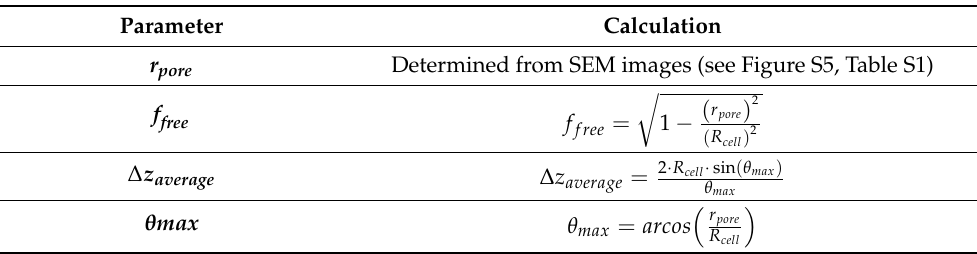
Table 2. Key topographic parameters investigated in this work (detailed description of geometric considerations is presented in Supplementary Materials